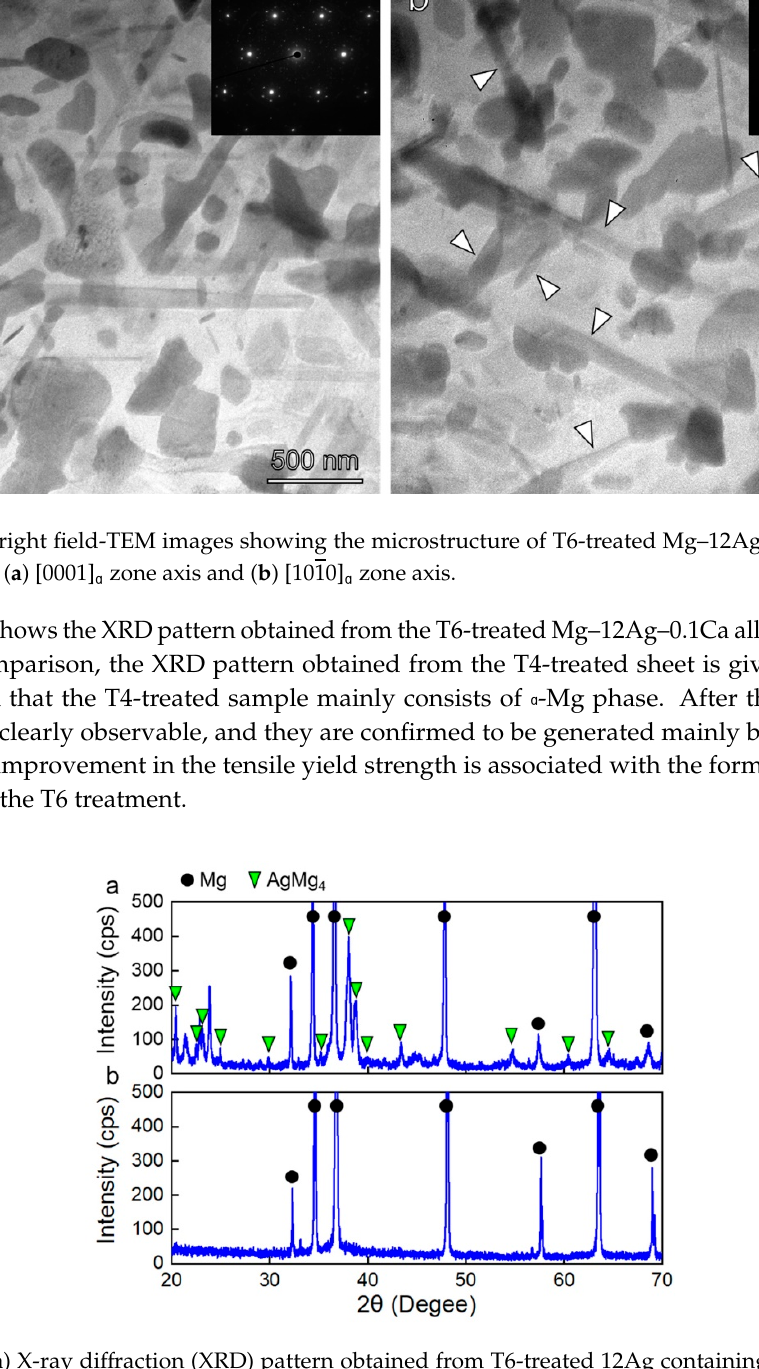
Figure 9. ( a ) X ‐ ray diffraction (XRD) pattern obtained from T6 ‐ treated 12Ag containing alloy sheet. For the purpose of comparison, XRD pattern obtained from T4 ‐ treated 12Ag containing alloy sheet is given in ( b ).